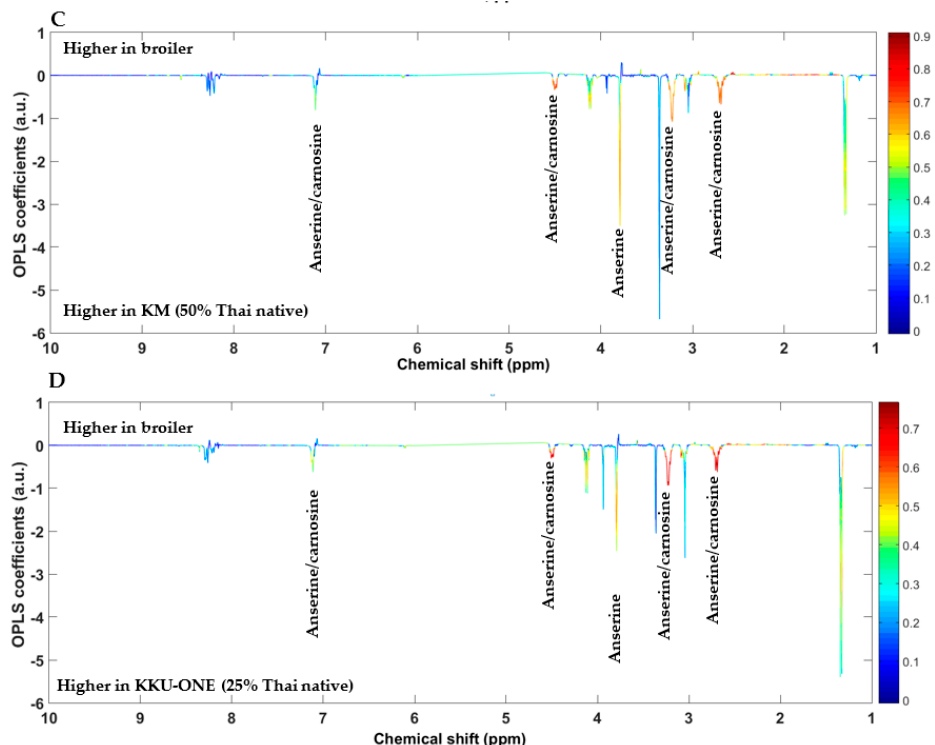
Figure 3. OPLS-DA loading plots discriminating metabolites of chicken breast extracts of ( A ) commercial broilers versus PD = Pradu Hang Dam Mor Kor 55 (100% Thai native), ( B ) commercial broilers versus CH = Chee KKU 12 (100% Thai native), ( C ) commercial broilers versus KM = Khai Mook E-san (50% Thai native), and ( D ) commercial broilers versus KKU-ONE (25% Thai native).